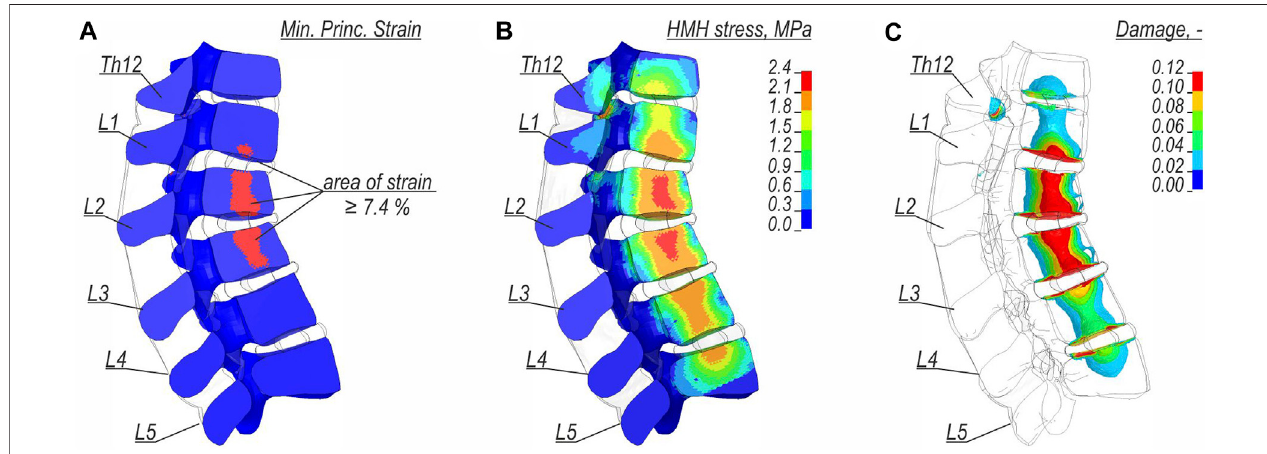
FIGURE7| Resultsforthedetailed lumbarspinemodel: (A) themap ofminimumprincipalstrain, (B) thefringeplotofHMHstresses,and (C) theisosurfacesofthe damage variable.